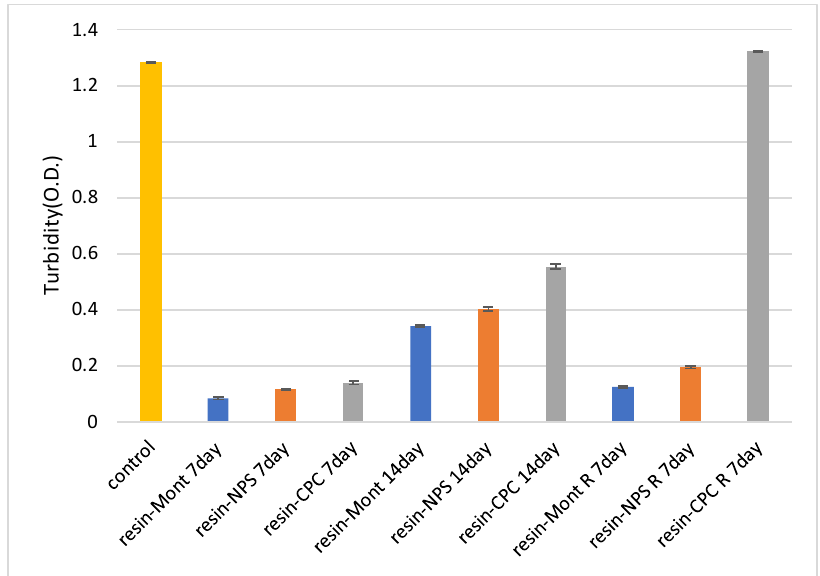
Figure 4. Comparison of variations in turbidity by antimicrobial test (“after reuptake” is denoted by “R”).